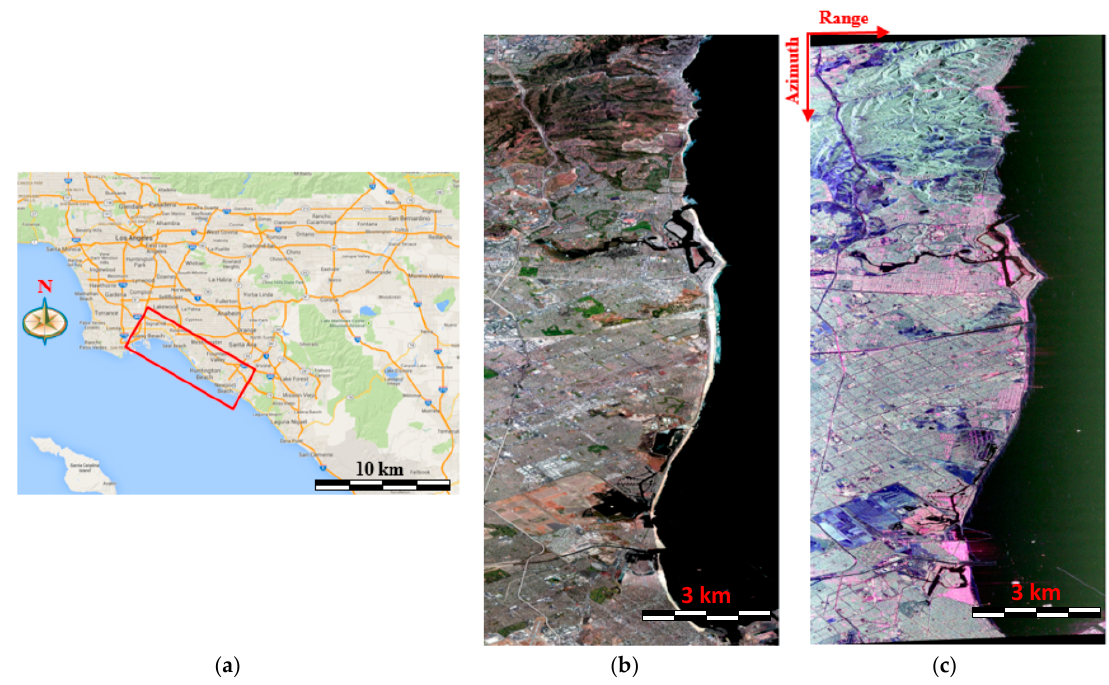
Figure 6. The optical image and PolSAR data of the study area: ( a ) map of the study area; ( b ) optical image that has been registered from Google Earth; ( c ) AIRSAR C band Pauli coded SAR image (red: |HH-VV|; green: |HV|; blue: |HH+VV|).